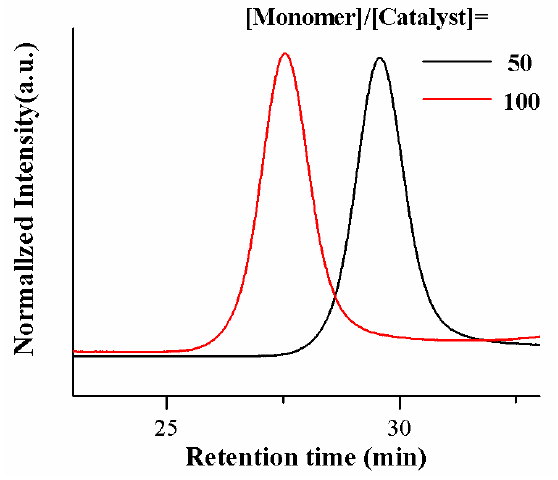
Figure 1. SEC chromatograms of L-P-M n prepared from isonitrile monomer with palladium catalyst as initiator in THF at 55 °C with different initial feed ratios. Table 1. Polymerization results of L-P-M n with palladium catalyst as initiator at 55 °C .